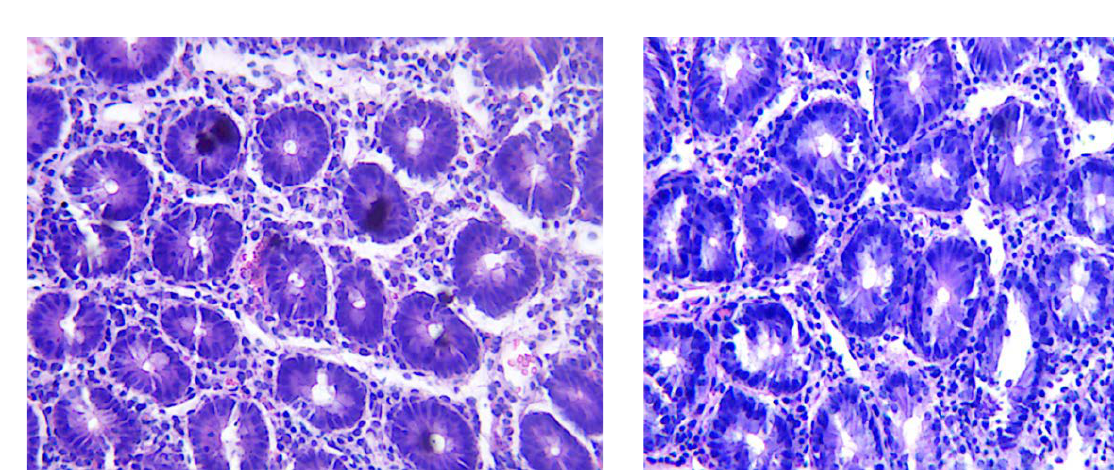
Fi gur e 2 b: M odel group.